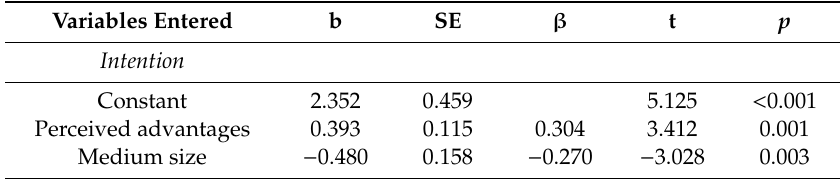
Table 2. Stepwise multiple regression: determinants of intention to join a food integrity information sharing system (FI-ISS) ( n = 111). Variables Entered